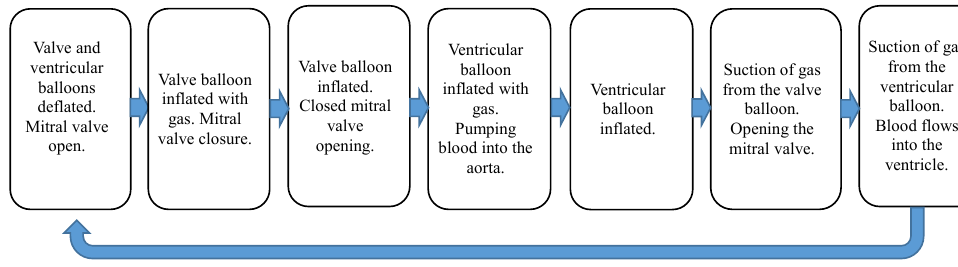
Figure 2. Principle of operation